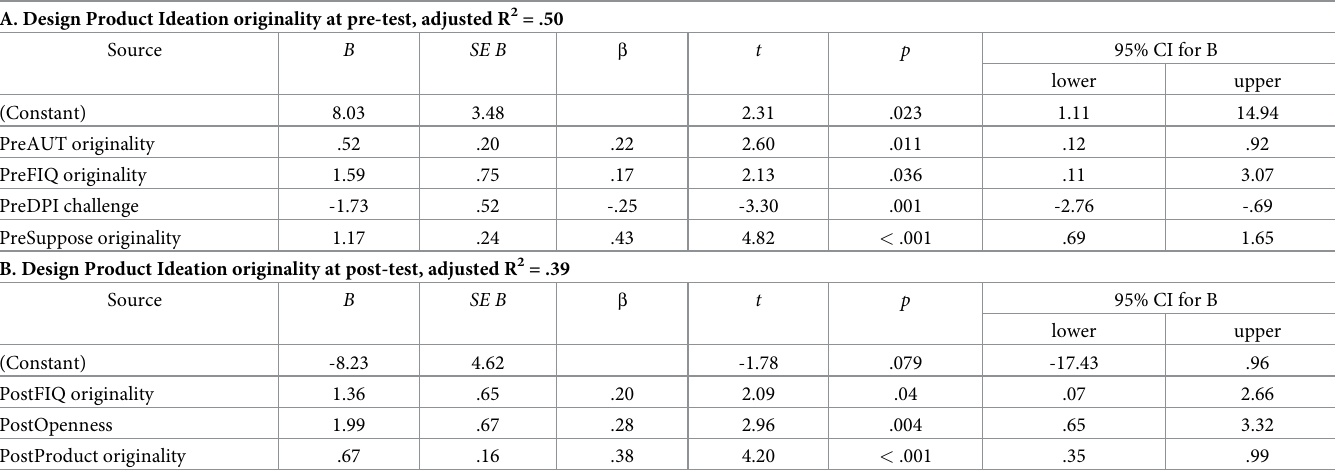
Table 7. Multiple regression on Design Product Ideation